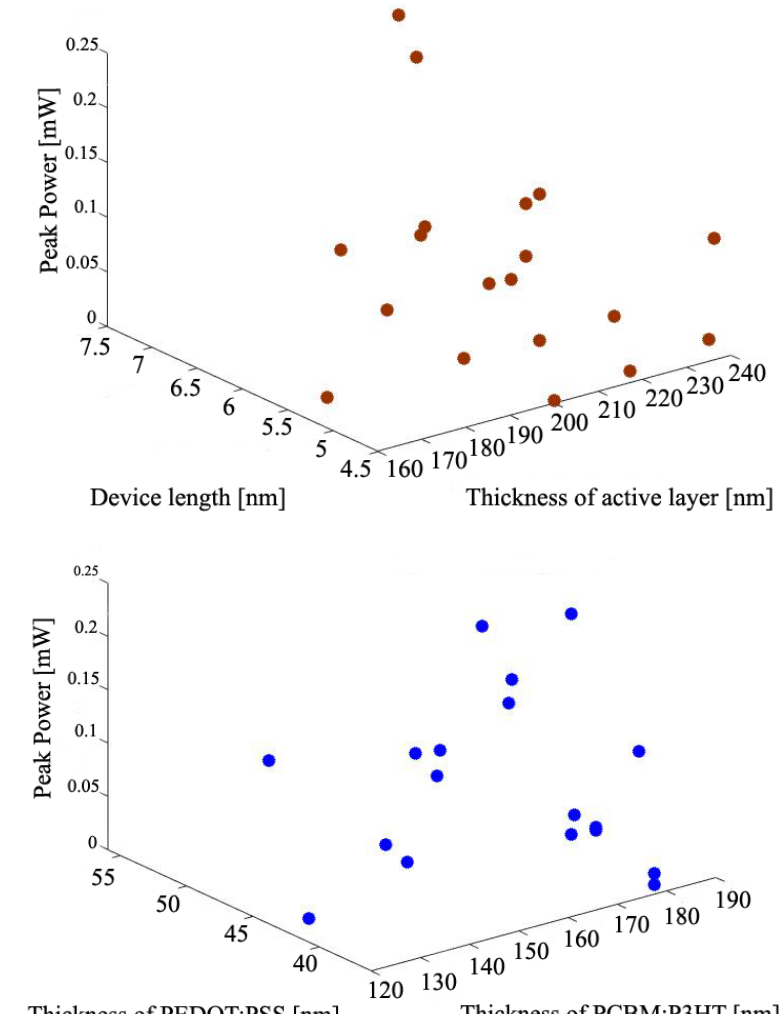
Figure 7. The figure shows the results of the trained neural network. On the top, the dependence of the generated power from the total thickness and length is reported. On the bottom, the power as a function of the PEDOT:PSS and PCBM:PSS thicknesses is